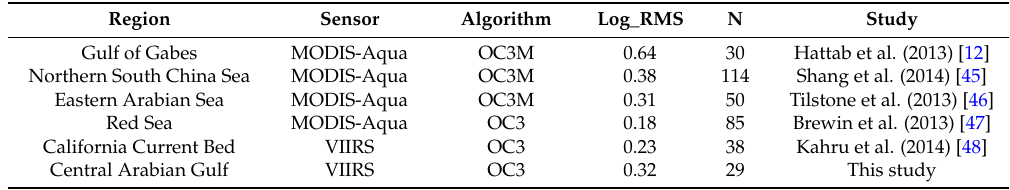
Table 1. A statistical comparison of the match-ups performed in the Arabian Gulf with those at complex coastal